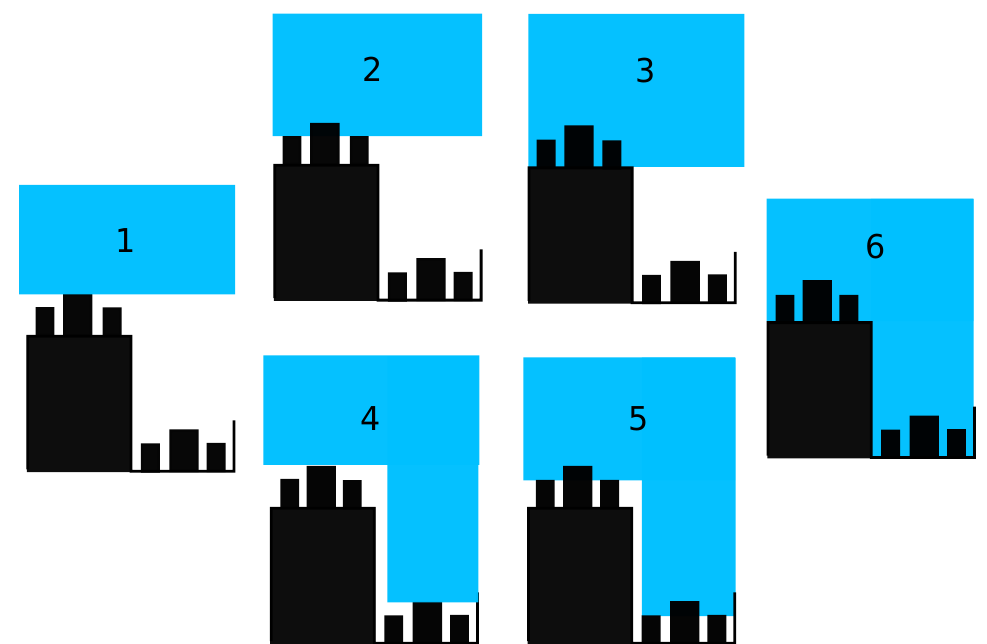
Figure 12. Schematic representation of the six wetting configurations investigated.